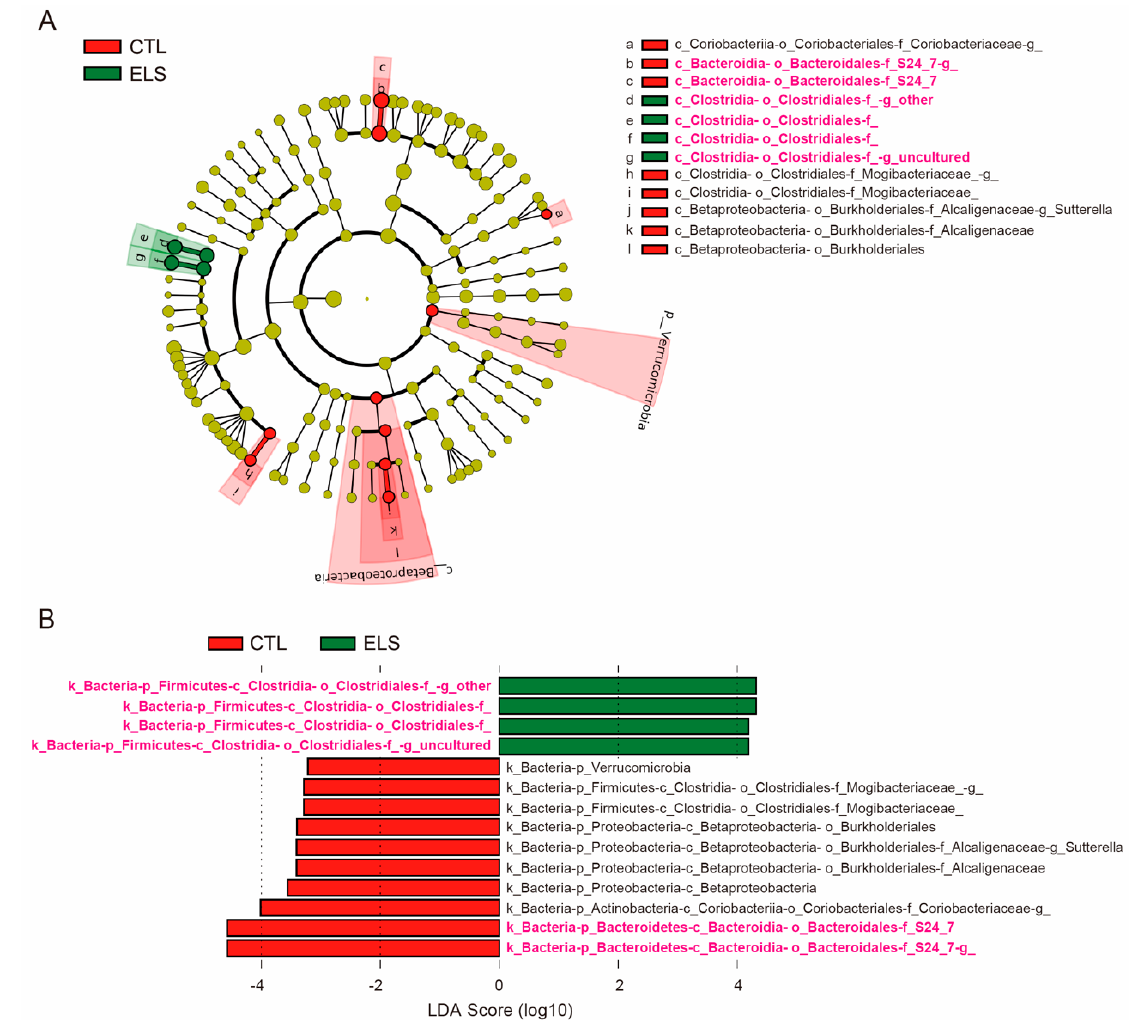
Figure 2. Linear discriminant analysis effect size in gut microbiota. Linear discriminant analysis effect size (LEfSe) showing relative taxonomic abundance at the genus level. ( A ) Cladogram by LEfSe. ( B ) LDA scores for differential gut microbiota by LEfSe. The s ignificantly altered gut bacteria in 16S rRNA-seq are shown in magenta. CTL, control mice; ELS, early life stressed mice, n = 5/condition.